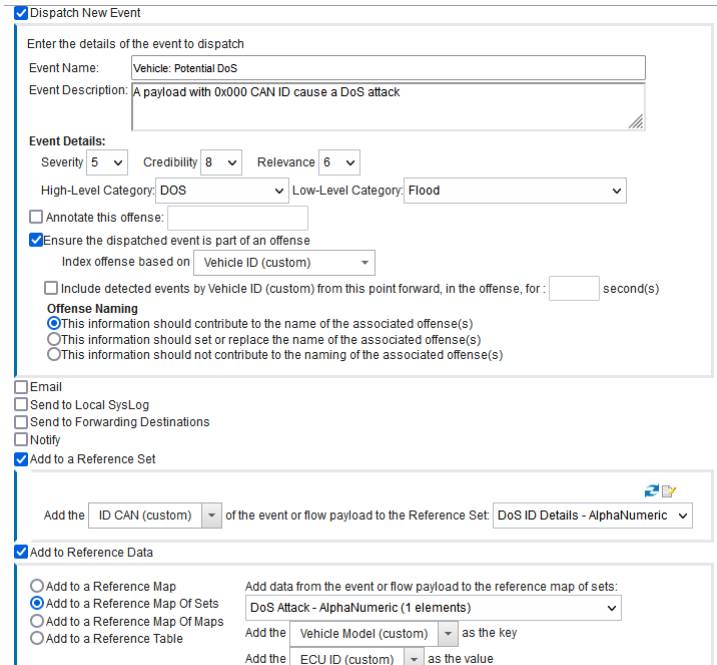
Figure 12. Rule Wizard with the field used to identify the DoS attack.